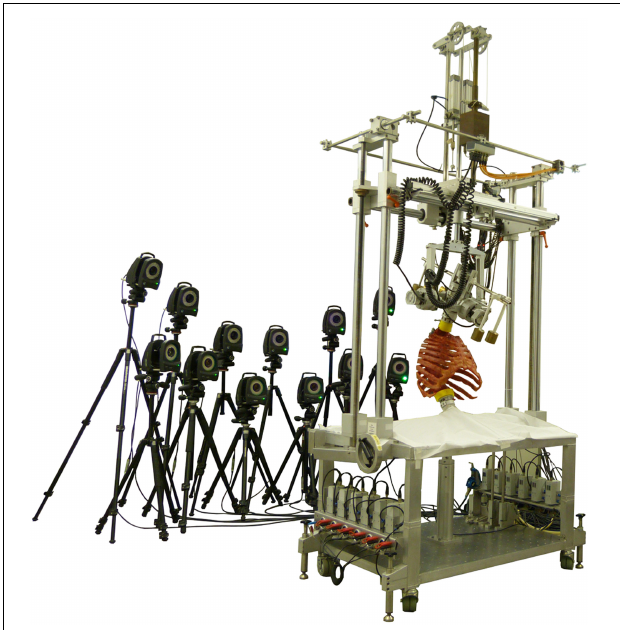
FIGURE 1 | Illustration of the test setup showing a rib cage specimen within the spine tester surrounded by the optical motion tracking system consisting of 12 cameras.